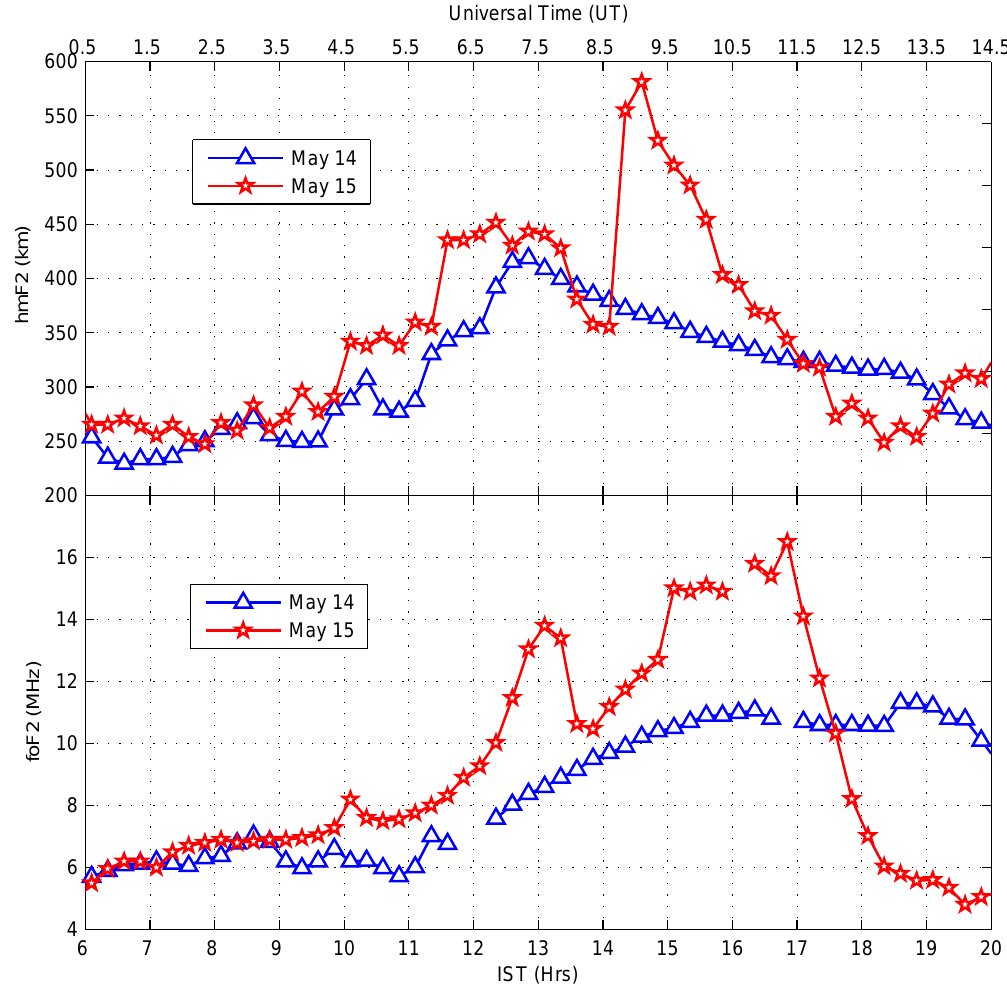
Fig. 5. Ionosonde data from New Delhi for the period of 14 and 15 May 2005. Variation of hm F2 (km) are shown in the upper panel and that of fo F2 (MHz) are shown in lower panel, with respect to Indian Standard Time (IST) on lowermost abscissa and UT on uppermost abscissa. Blue triangle markers represent values of parameters on 14 May and red star markers with red line represent that on 15 May